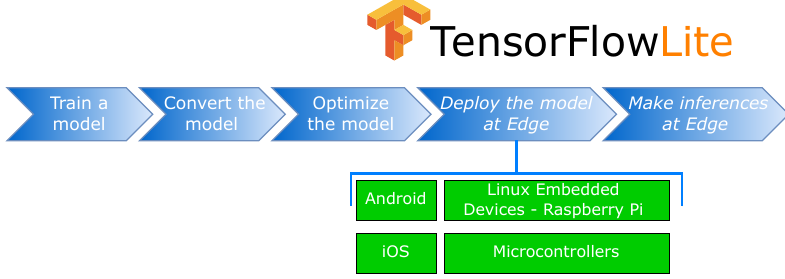
Figure 15. Standard pipeline for TensorFlow